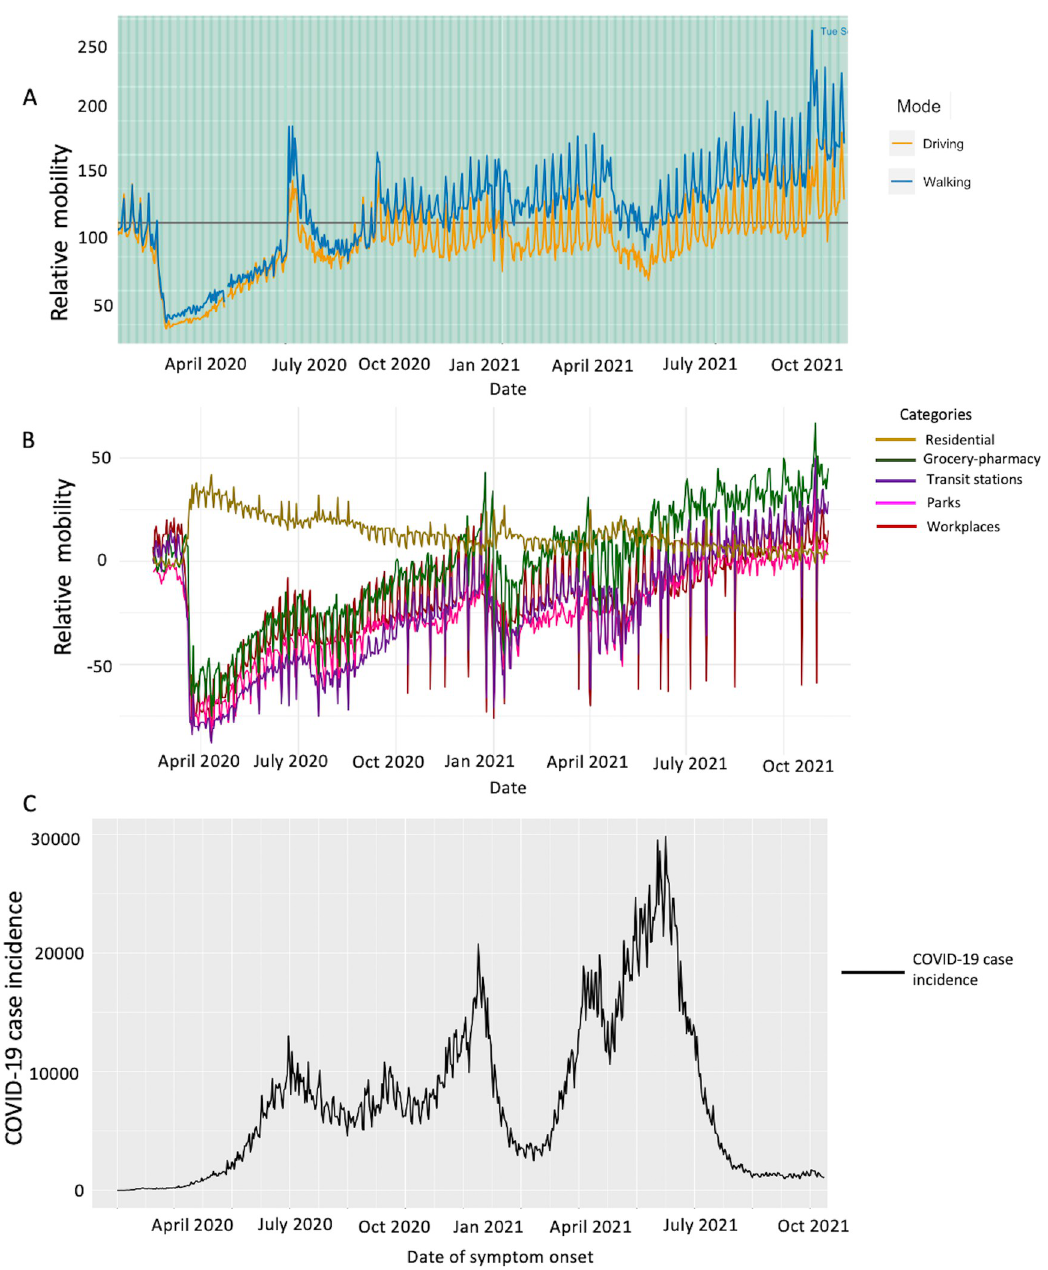
Fig 13. Panel A: Apple mobility trends data showing the variation in walking and driving among the population in Colombia. Orange curve shows the driving trend, and the blue curve shows the walking trend. Panel B: Google mobility trends data showing the variation in movement of people in Colombia across the following categories: grocery and pharmacy (green solid curve), parks (pink solid curve), transit stations (purple solid curve), workplaces (red solid curve) and residential areas (golden solid curve). Panel C: The COVID-19 incidence curve in Colombia by the dates of symptoms onset as of October 31, 2021.